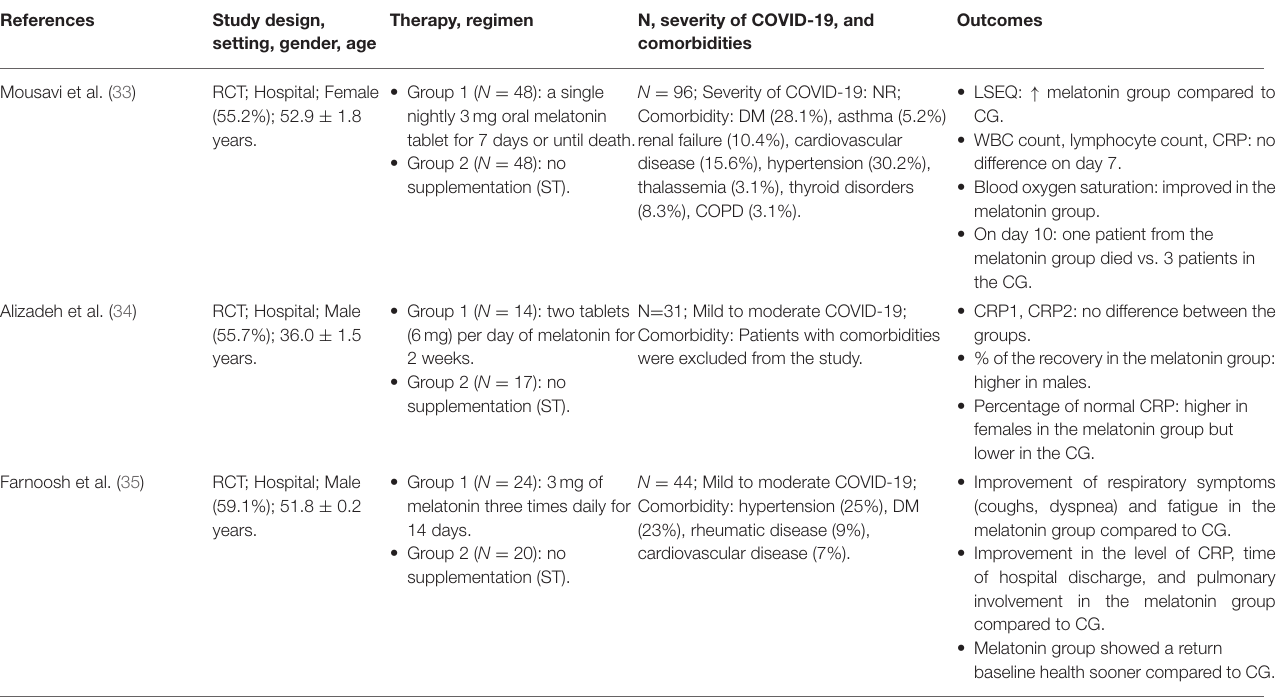
TABLE 1 | Summary of findings from studies that included melatonin supplementation in the COVID-19 treatment.